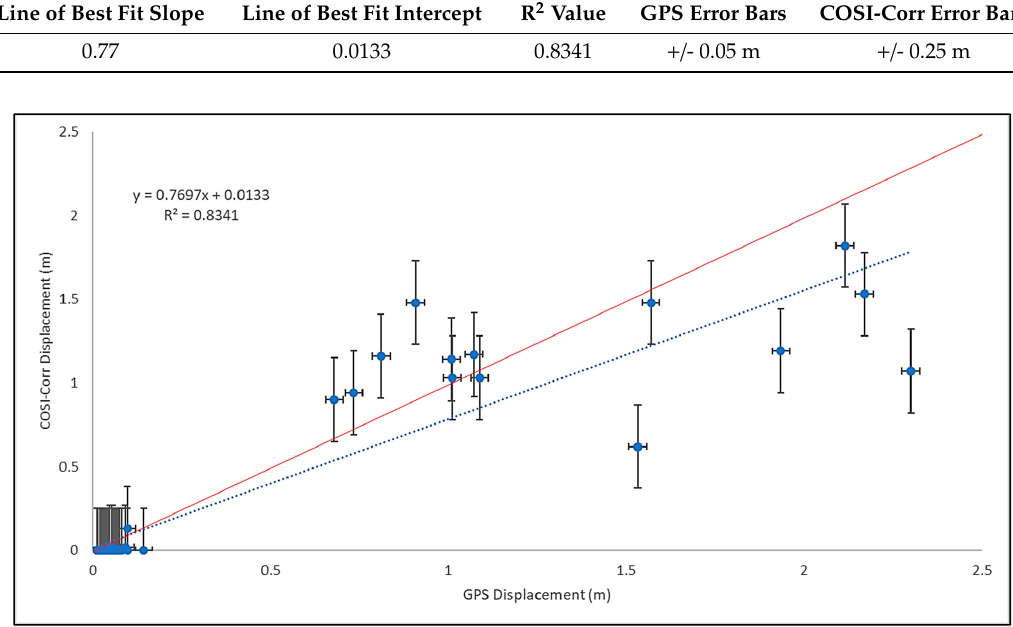
Table 4. GPS displacement and COSI-Corr displacement comparison between 2012 and 2016 at 55 GPS stations (information from Figure 6). Figure 5. Average velocity time series with GPS (solid curve) and COSI-Corr (dashed curve) at GPS station UB-2 located at the toe of AcPB (the most active region of the Portuguese Bend landslide complex).